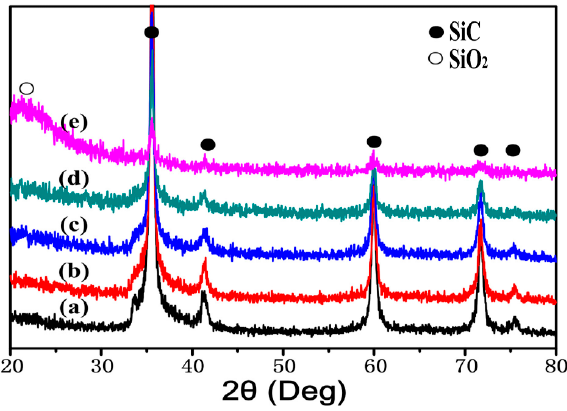
Figure 2. XRD patterns of nano-SiC particulates with different pre-oxidation parameters of: ( a ) untreated; ( b ) 973 K/2 h; ( c ) 1073 K/2 h; ( d ) 1173 K/2 h and ( e ) 1273 K/2 h.